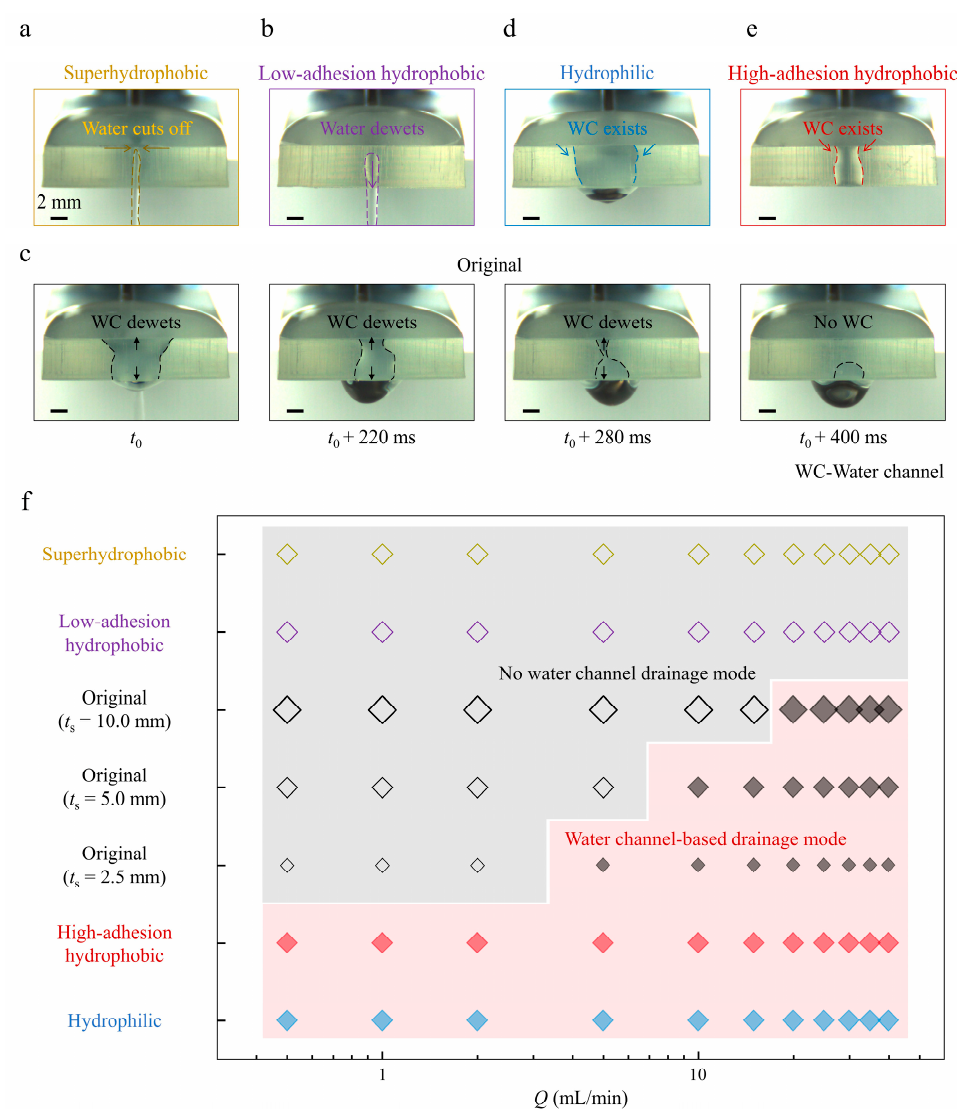
Figure 4. Critical drainage snapshots and phase map of the two drainage modes. ( a – e ) A series of critical front drainage snapshots demonstrating various marginal water channel conditions for different margin modifications. ( f ) Phase map for samples of varying margin modifications and thicknesses versus water flow rates Q .